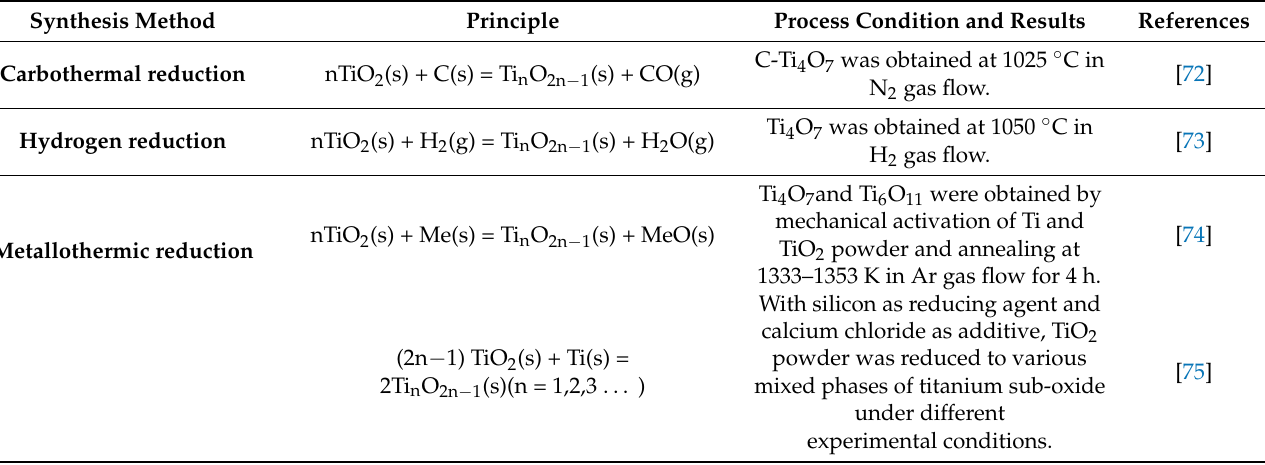
Table 3. Synthesis methods of titanium sub-oxides powder with TiO 2 as